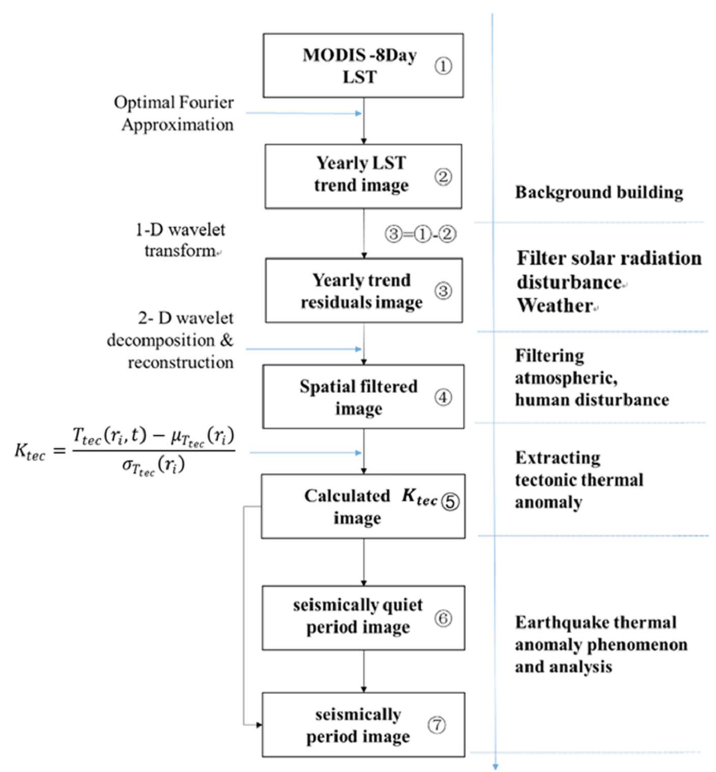
Figure 4. Detailed flow chart of the proposed new algorithm.